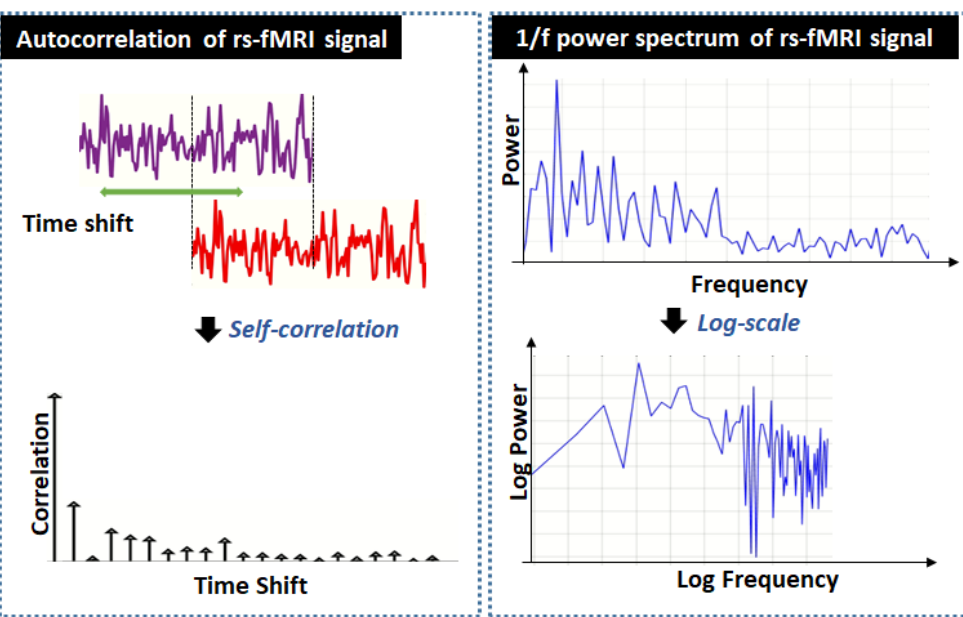
Figure 1. Autocorrelation and power spectrum fractal properties of rs-fMRI signals.